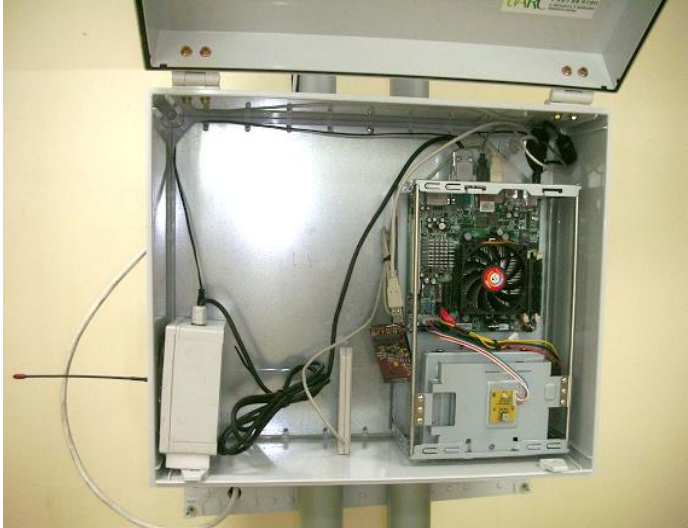
Figure 11. Agricultural Environment Monitoring Server (Database, Web